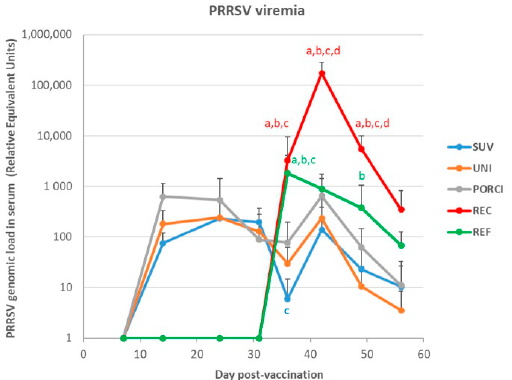
Figure 3. Results of the RT-qPCR analyses of serum samples following vaccination and challenge expressed as relative equivalent units (REUs). The pigs in the SUV, UNI and PORCI groups were vaccinated with the vaccine Suvaxyn PRRS, Unistrain or Porcilis PRRS at day 0 post-vaccination (dpv) and challenged at dpv 28 with the recombinant Horsens strain together with an unvaccinated group of pigs (REC). Another group of unvaccinated pigs was challenged on dpv 28 with a reference strain (REF). Different letters indicate significant difference obtained comparing the considered group to the SUV group (a), the UNI group (b), the PORCI group (c) or the REF group (d), with p < 0.05.